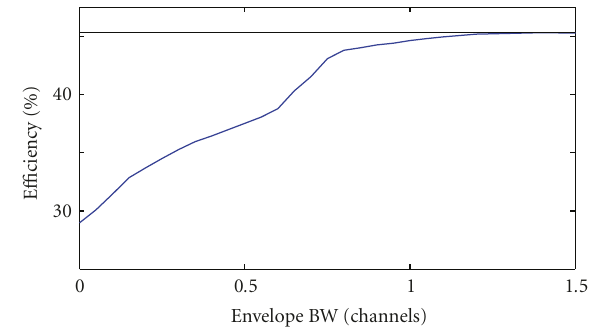
Figure 11: Average e ffi ciency versus envelope bandwidth for an OFDM